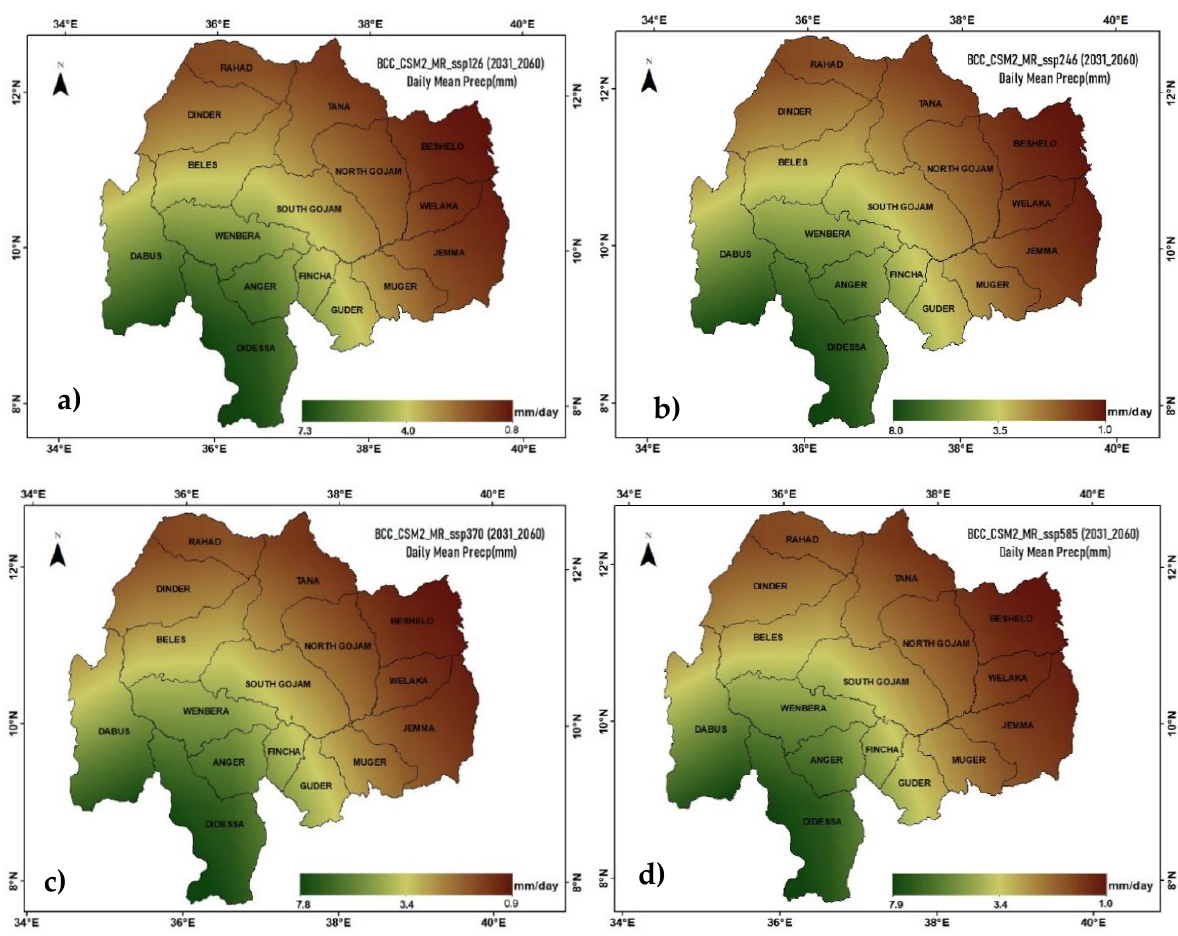
Figure 9. Spatial distribution of CMIP6-BCC-CSM2-MR model daily mean precipitation(mm/day) for ( a ) SSP126 (0.8–7.3), ( b ) SSP245(1.0–8.0), ( c ) SSP370 (0.9–7.8), and ( d ) SSP585 (1.0–7.9) scenarios over the UBNB for the near-term projections (2031–2060). The spatial distributions of mean precipitation for four SSP scenarios looks identical but the range of the value is different.